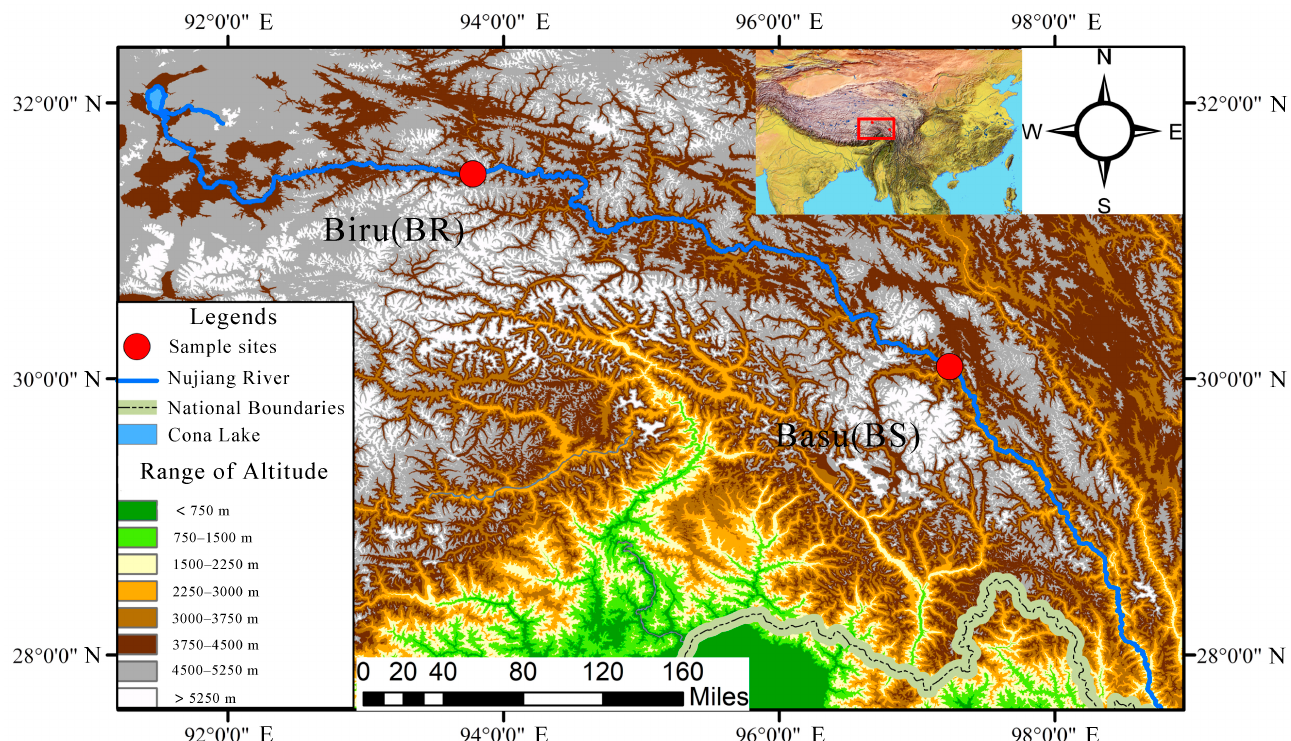
Figure 1. Sampling sites of S. nukiangensis in this research.